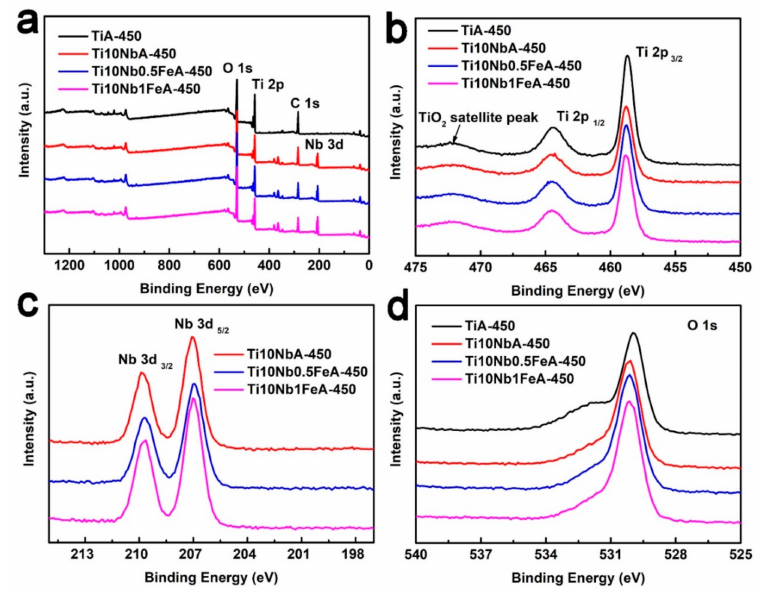
Figure 8. The XPS spectra of annealed nanotubes based on Ti and Ti10NbxFe alloys: survey scan ( a ),